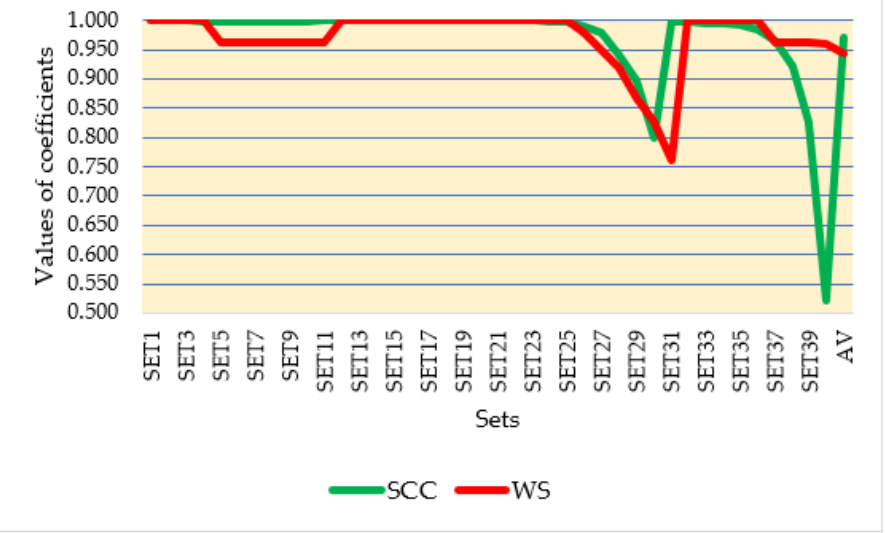
Figure 5. Statistical SCC and WS correlation coefficients for changes in criterion significance.